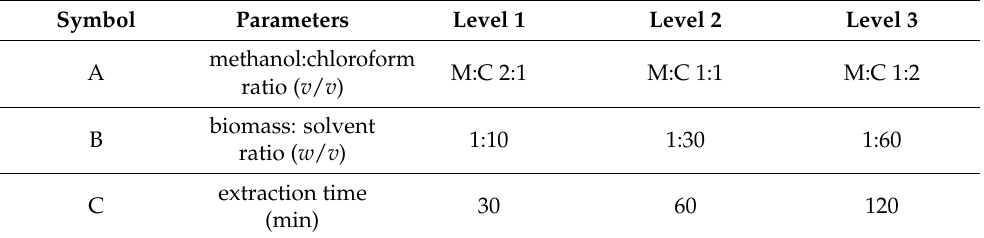
Table 5. Process parameters and their levels for lipid extraction.